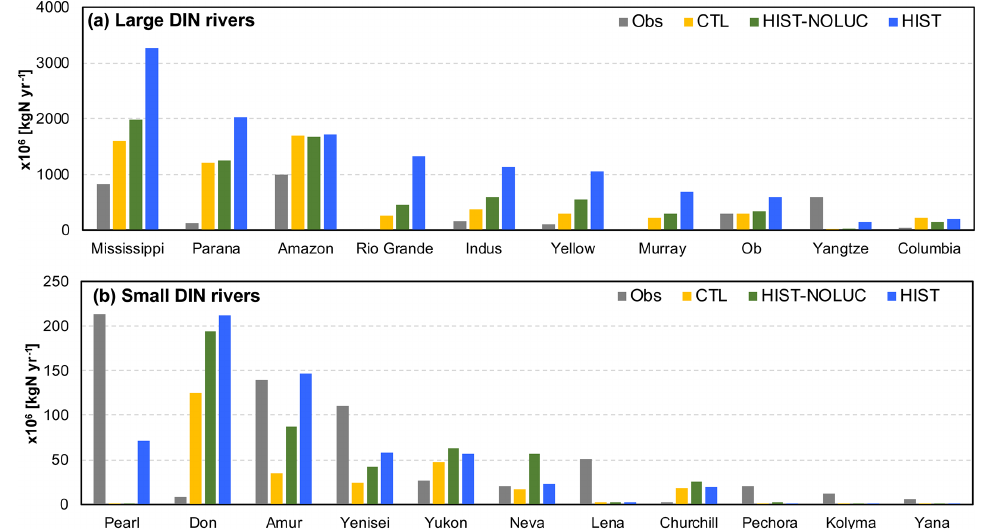
Figure 17. Simulated and observed DIN load per river basin: sorted by simulated (a) first 10 largest rivers and (b) second 10 largest rivers. Vertical gray bars represent observations (Dumont et al., 2005); blue, green, and yellow bars correspond to the results of the HIST, HIST- NOLUC, and CTL experiments, respectively. Table 5. Comparison of TCR, AF, and TCRE between MIROC-ES2L, MIROC-ESM, MIROC5.2, and CMIP5 ESMs in the 1PPY simulation. For MIROC-ES2L, both TCR and AF are calculated based on 20-year means of T2, CL, and CO centered on the 70th year of the 1PPY simulation (i.e., the time when the CO 2 concentration is doubled from the preindustrial condition), and TCRE is calculated based on TCR and AF. Numbers for the CMIP5 ESMs were obtained from Gillett et al. (2013) and are presented as the multimodel mean ± 1 σ . TCR (K) AF (–) TCRE (KEgC − 1